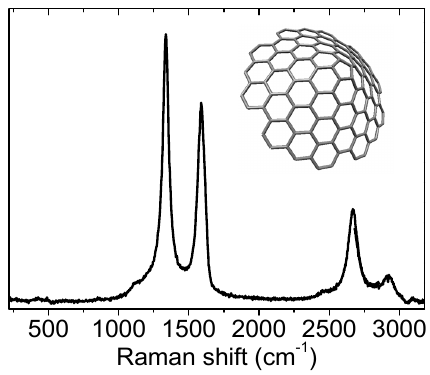
Figure 15. Typical Raman spectrum of a nanocone. The insert is an illustration.